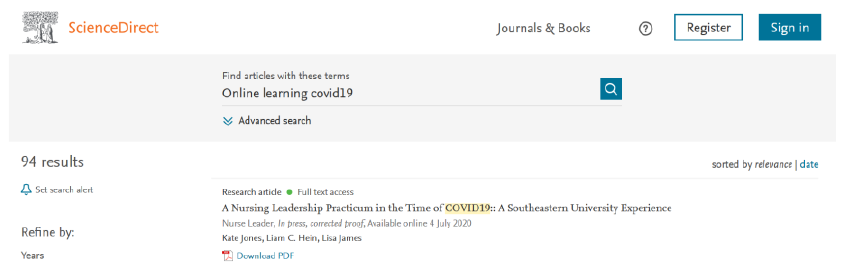
Fig. 2. Relevant research paper